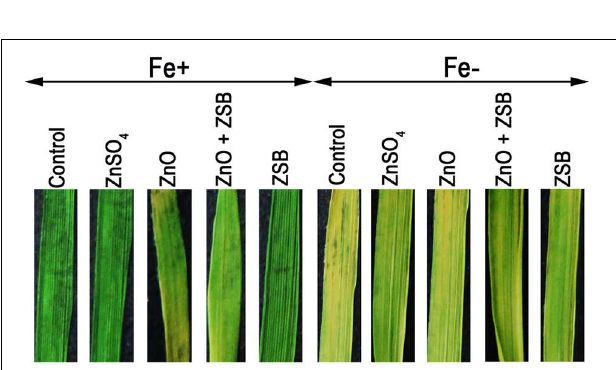
FIGURE 4 | Leaf color of 14-days-old rice seedlings after exposure to different Zn treatments under Fe + and Fe − conditions. Control, No-zinc control; ZnSO 4 at 5 mM; ZnO at 10 mM; ZSB, Zinc solubilizing bacteria ( Enterobacter cloacae strain ZSB14) inoculation on 7th